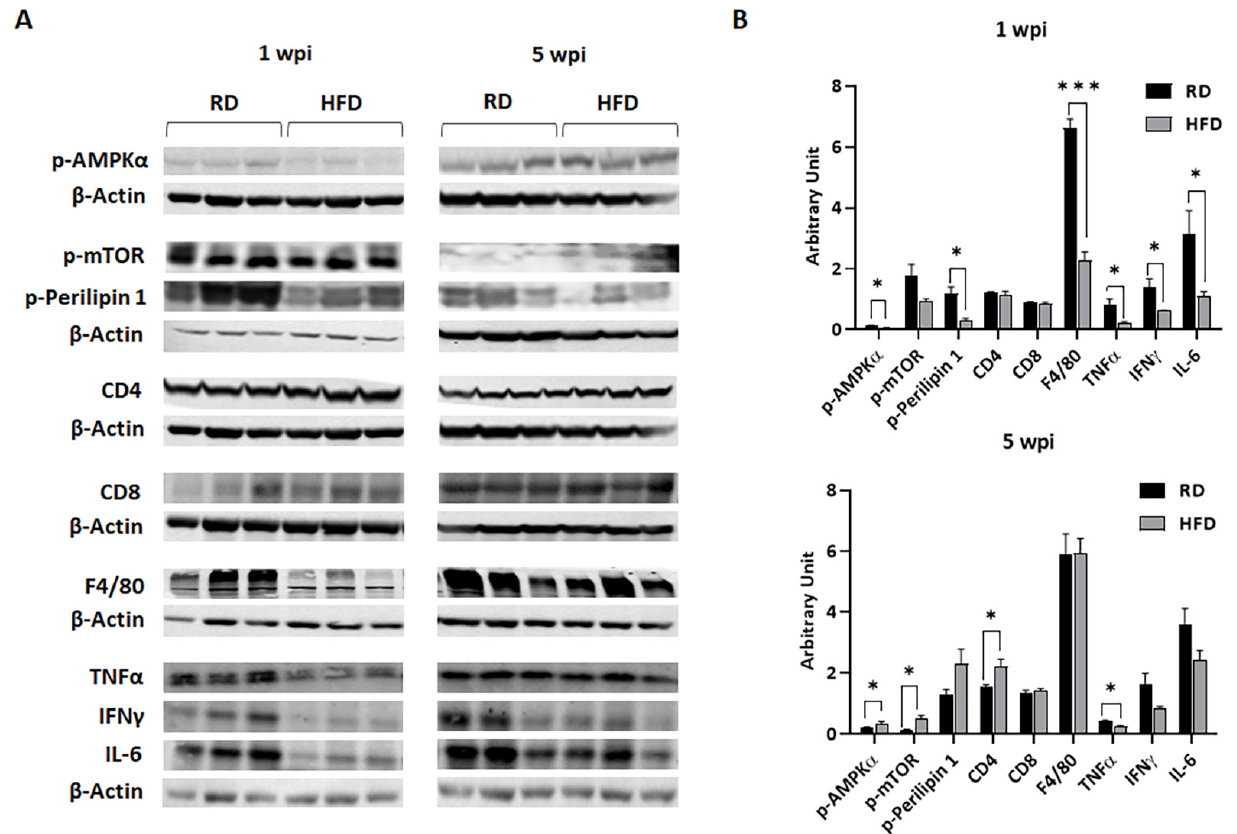
Figure 5. RD and HFD differently regulate the expression levels of p-AMPK α , p-mTOR, p-Perilipin 1, CD4, CD8, F4/80, TNF α , IFN γ , and IL-6 in tumor-associated mammary fat pad during early (1 wpi) and later (5 wpi) time points of tumor growth in young female E0771 tumor-bearing mice. ( A ) Immunoblots showing different protein expression between RD and HFD at 1 wpi and 5 wpi. β -Actin was used as loading control. ( B ) Bar graphs showing the levels of each protein marker nor- malized to β -Actin (top panel—1 wpi; bottom panel—5 wpi). The error bars represent the standard error of the mean. * p ≤ 0.05 and *** p ≤ 0.001.